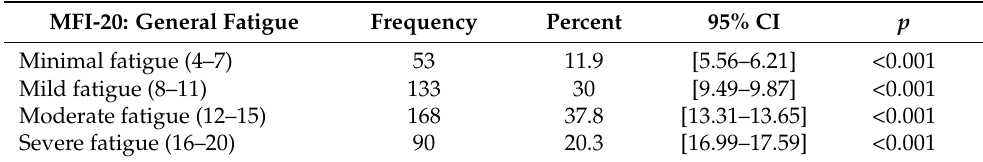
Table 4. The frequencies of the MFI-20 self-reported categories. MFI-20: General Fatigue